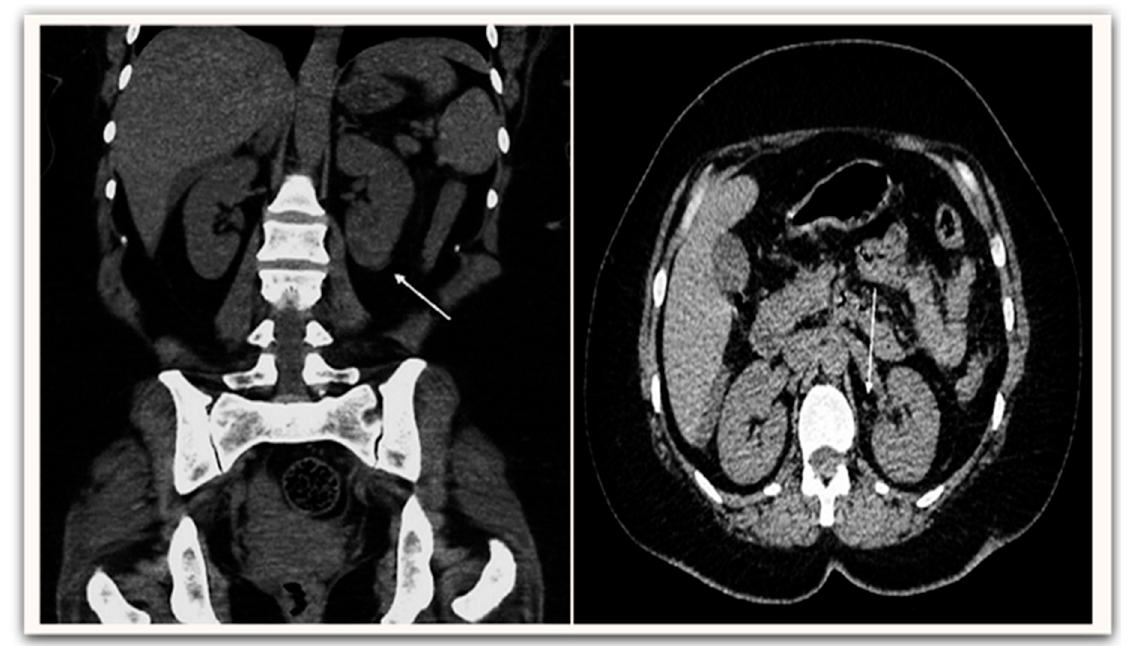
Figure 3. Non-enhanced abdominal CT scan demonstrates perinephric fat stranding (white arrow) with irregularity of the outer border of the kidney. Table 4. Laboratory indices of COVID-19 patients on